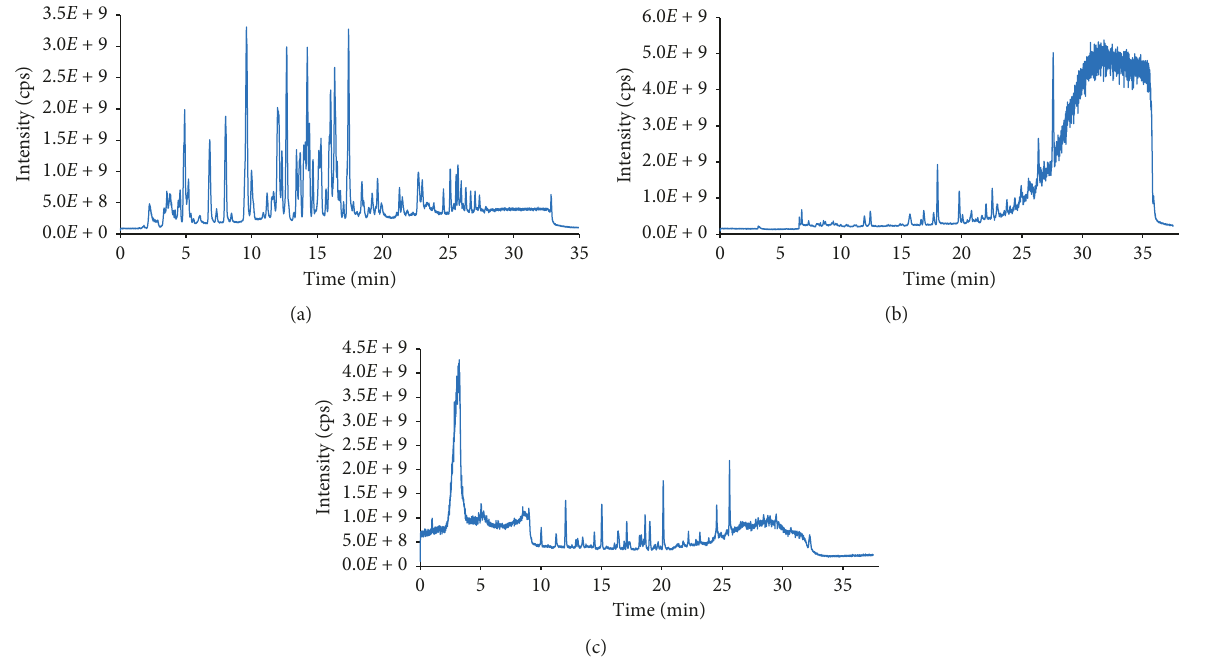
Figure 2: Total chromatogram of multiclass pesticides on the different stationary phases: (a) PFP column; (b) Hypersil ODS; (c) HyperClone ™ 5 μ m ODS 120 ˚A. Table 1: Short-term and long-term stabilities of retention time of three target analytes in the standard solution and in the real matrix. No